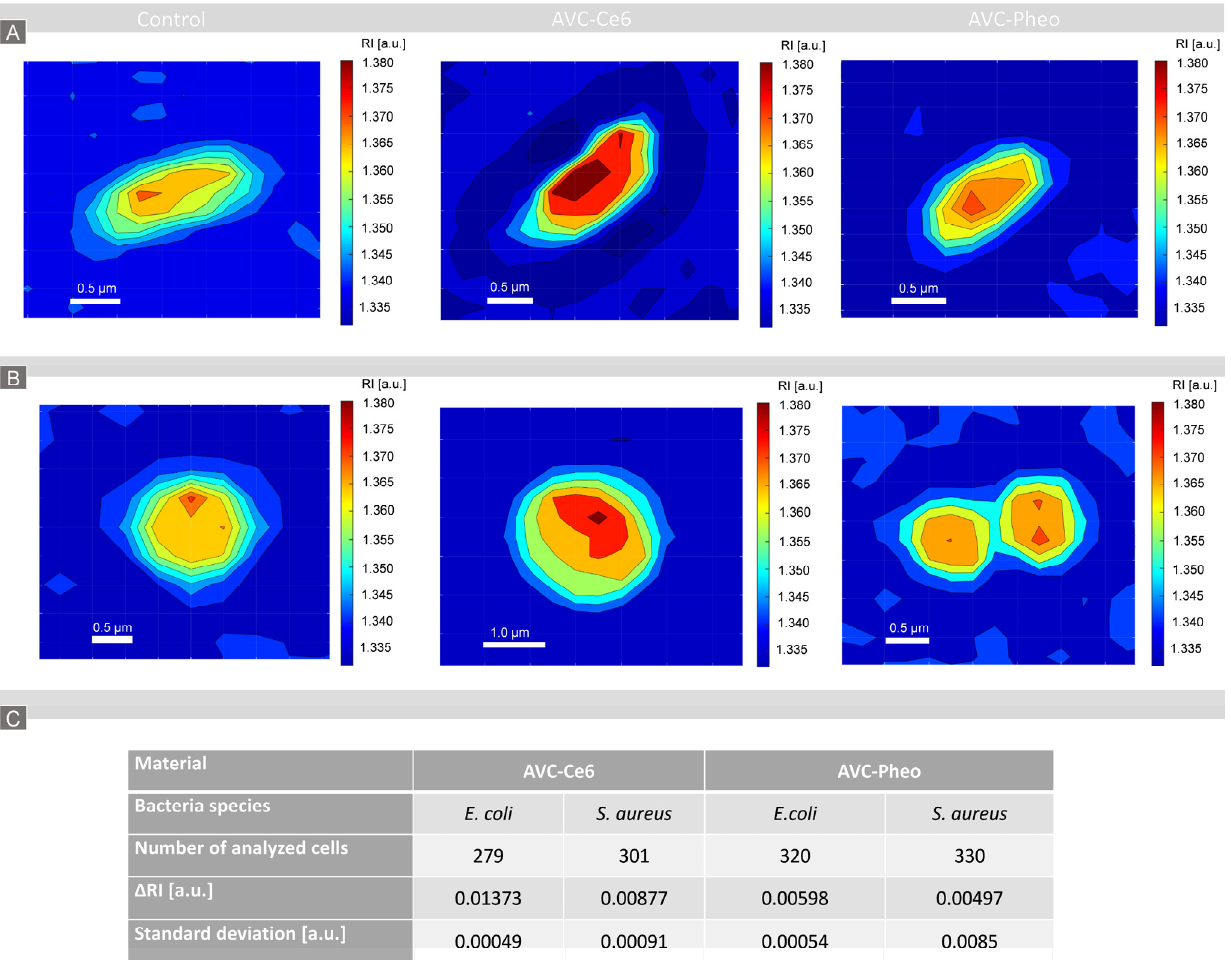
Figure 3. The representative 2D-RI maps of single E. coli ( A ) and S. aureus ( B ) cells on AVC (control), AVC-Ce6, AVC-Pheo materials and the averaged RI differences with standard deviations ( C ).